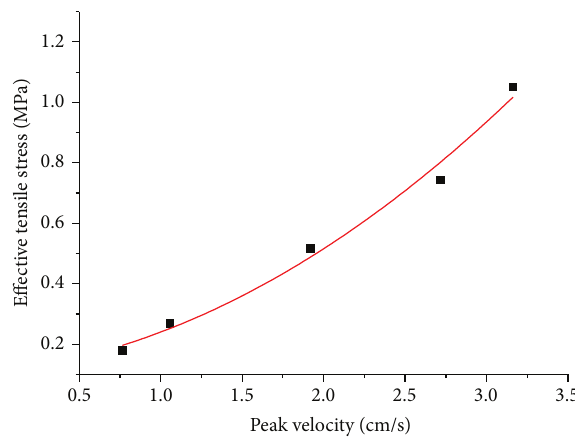
Figure 15: Safety criterion in tunnel